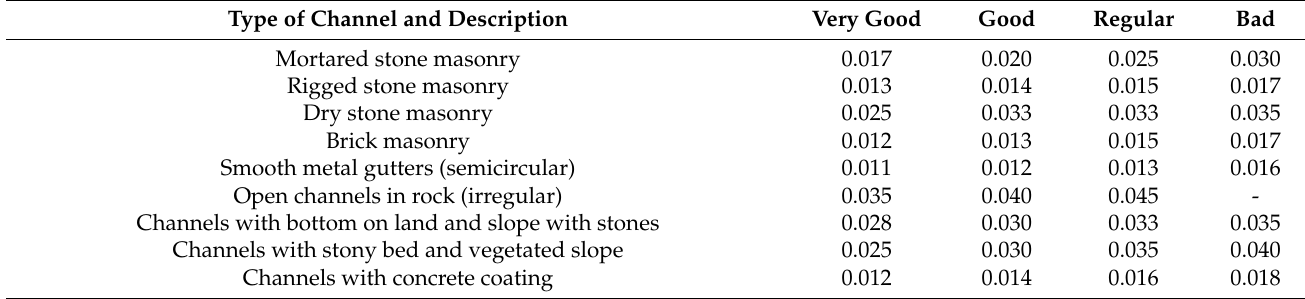
Table A1. Manning–Strickler roughness coefficients (Source: